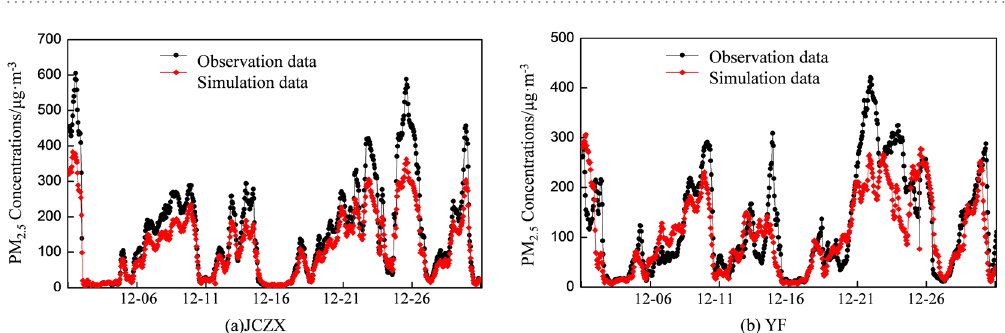
Figure 7. Comparisons between observed and simulated PM 2.5 concentrations in December 2015 at two stations in